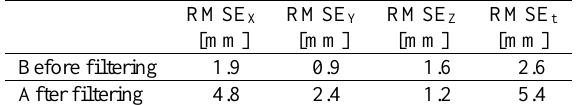
Table 3. The RMSE of the GCPs before and after filtering of the video network.